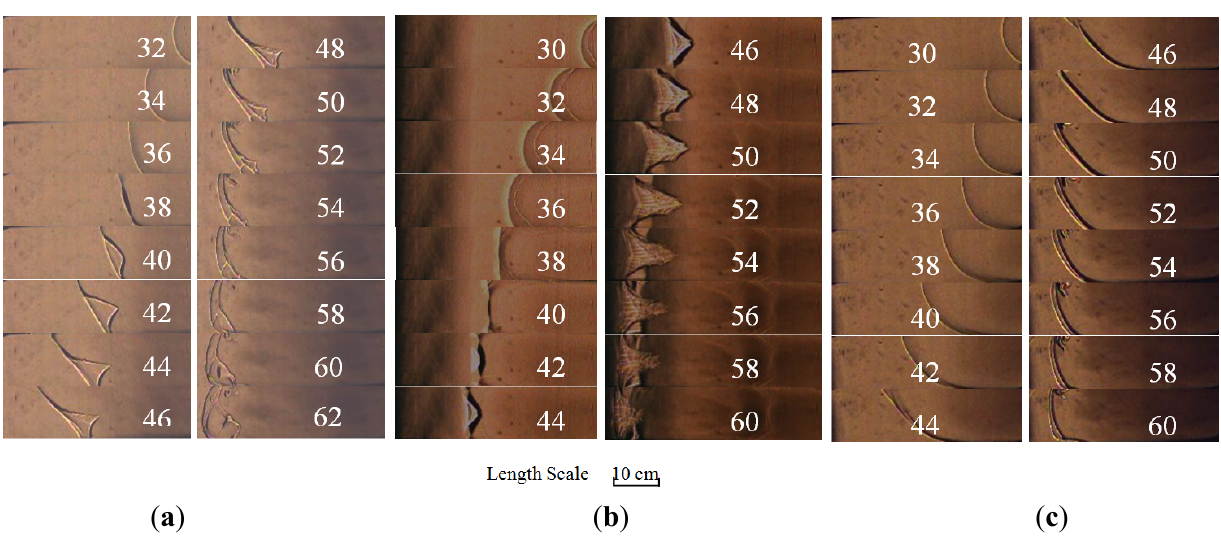
Figure 1. High speed Schlieren images of flames at different volume